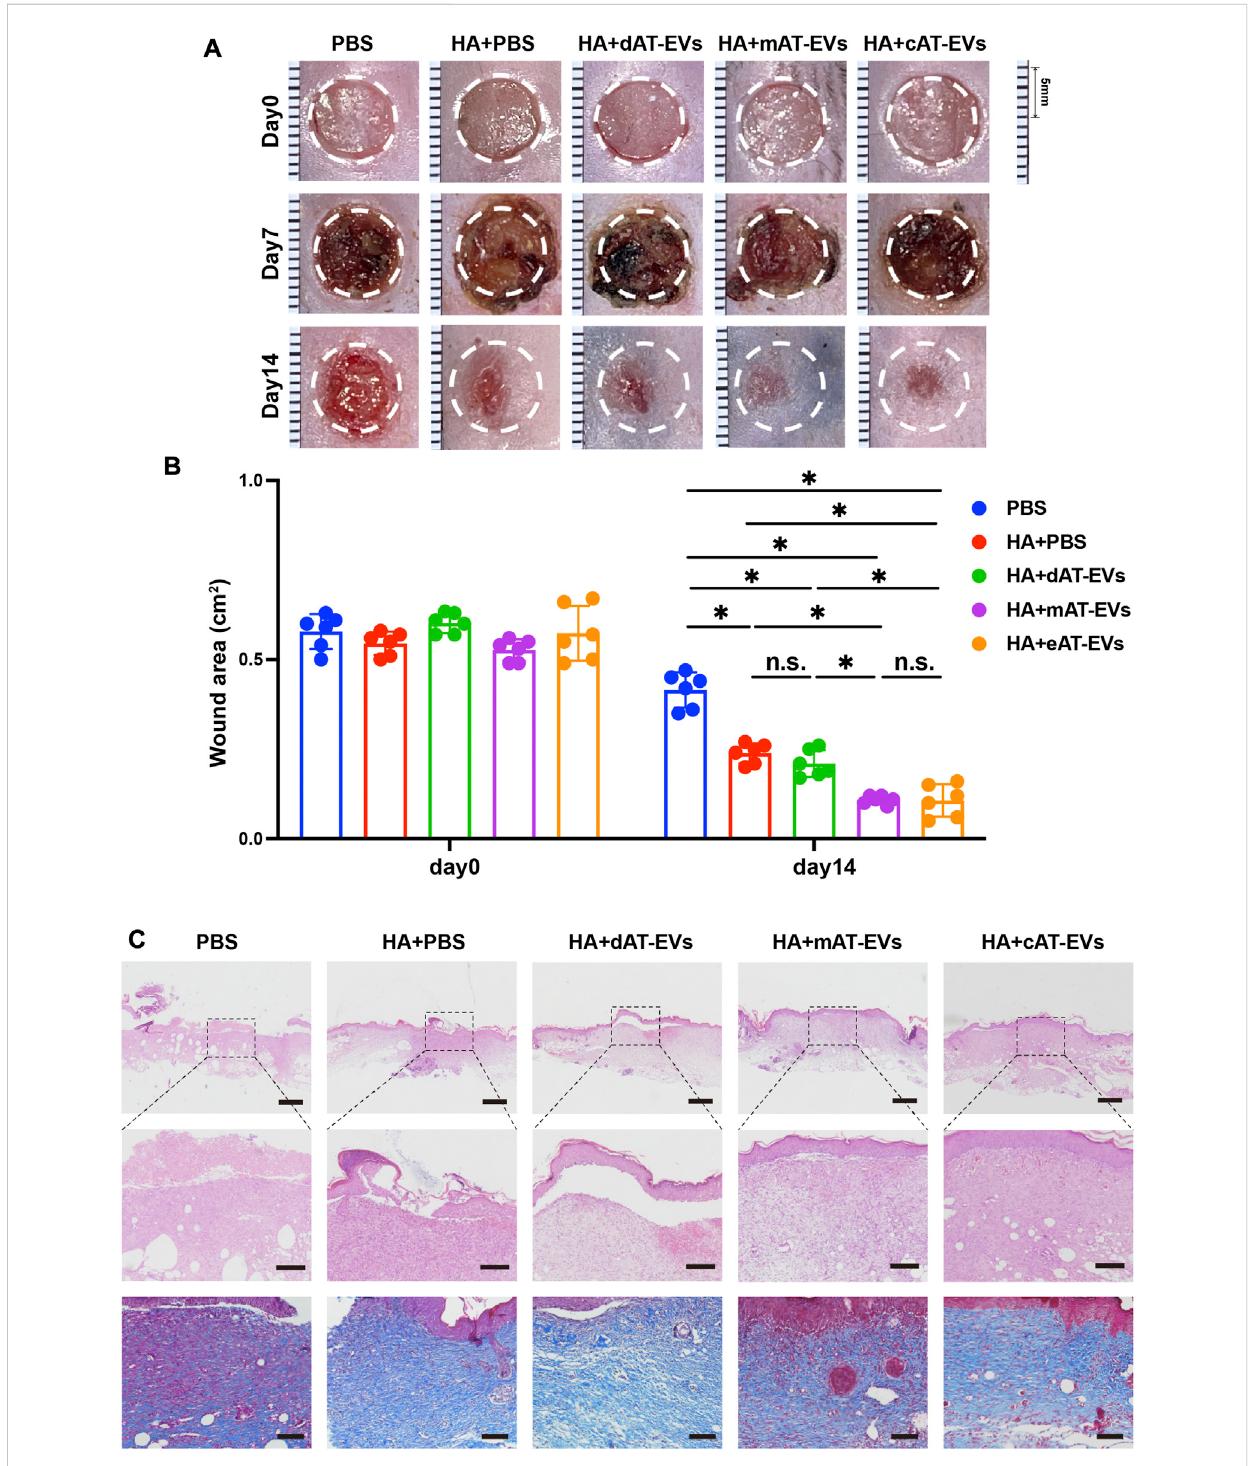
FIGURE 7 AT-EVs promotedchronic wound healing in diabetic mice (A) Representative photographs of mouse wounds atdays 0, 7, and 14. Scale bar = 1 mm. (B) Statistical analysis of the wound area ( n = 6). (C) H&E and Masson staining of wound tissue sections, observed under a light microscope. Scale bar = 500 μ m (top), 150 μ m (middle), 100 μ m